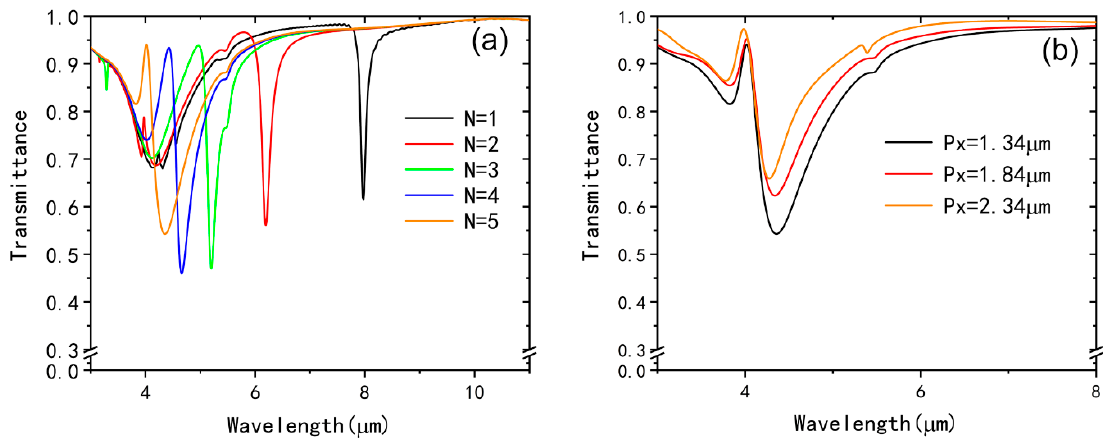
Figure 3. ( a ) Transmission spectra of the individual graphene split-ring with different layers. ( b ) Transmission spectra of the structure with different periods (Px) in the x direction.